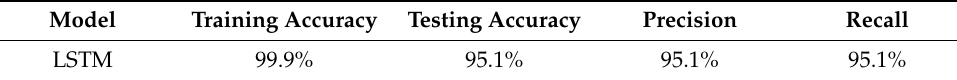
Figure 5. Accuracy curve for the LSTM model. Table 5. The results of training and testing for the LSTM model.